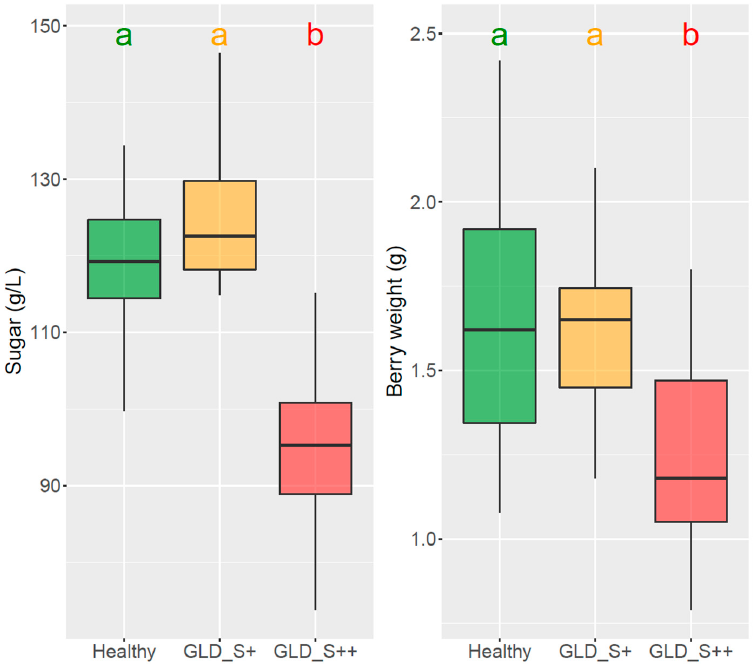
Figure 2. Single berry sugar content and berry weight and at veraison (14.8.18) in Vitis vinifera cv. Pinot noir on rootstock 5BB infected or not by leafroll disease. Means were denoted by different letters (a,b) when they differ significantly at p < 0.001 using Ducan’s new multiple range test. N = Healthy (symptomless): 31; GLD_S+: 15; GLD_S++: 25. GLD_S+: Grapevine leafroll disease causing mild symptoms; GLD_S++: grapevine leafroll disease causing severe symptoms. The seasonal evolution of leaf chlorophyll content is shown in Figure 3. Compared to symptomless control, treatment GLD_S++ showed a drastic reduction in leaf chloro- phyll content and this was already observable in mid-June. The chlorophyll content of the GLDS+ treatment leaves always remained between that of the symptomless control and that of GLD_S++. For both treatments, a significant reduction in leaf chlorophyll content could be measured even before the appearance of visible symptoms. These observations were consistent over the three years of measurements. In particular, during 2015, leaf chlo- rophyll content for symptomless control increased from June to August (veraison). On the contrary, leaf chlorophyll content for GLD_S++ was constantly diminishing during the same period and it reached 33% of the leaf chlorophyll content measured from the symp- tomless control at veraison while the level remained flat during the same period for GLD_S+.